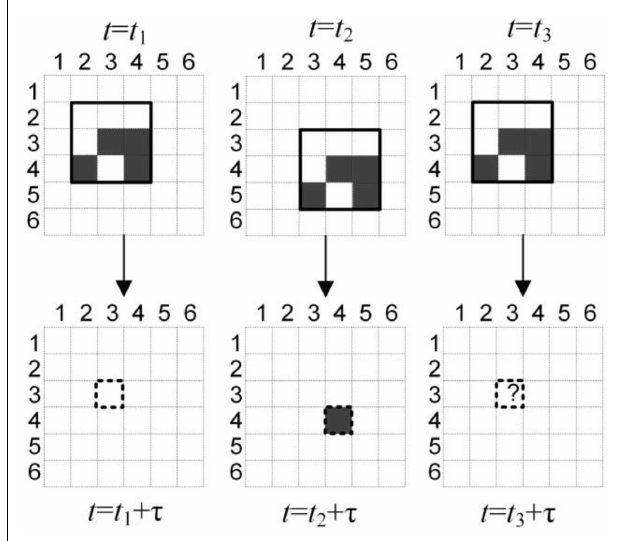
FIGURE 6 | Illustration of Bernoulli trials of neighborhood matching . Solid squares: neighborhoods with the same neighborhood pattern. Filled squares: occupied cells detected by UAVs. Empty squares: unoccupied cells detected by UAVs. Dashed squares: corresponding cells associated with the neighborhoods. Squares with a question mark: unknown cells which need